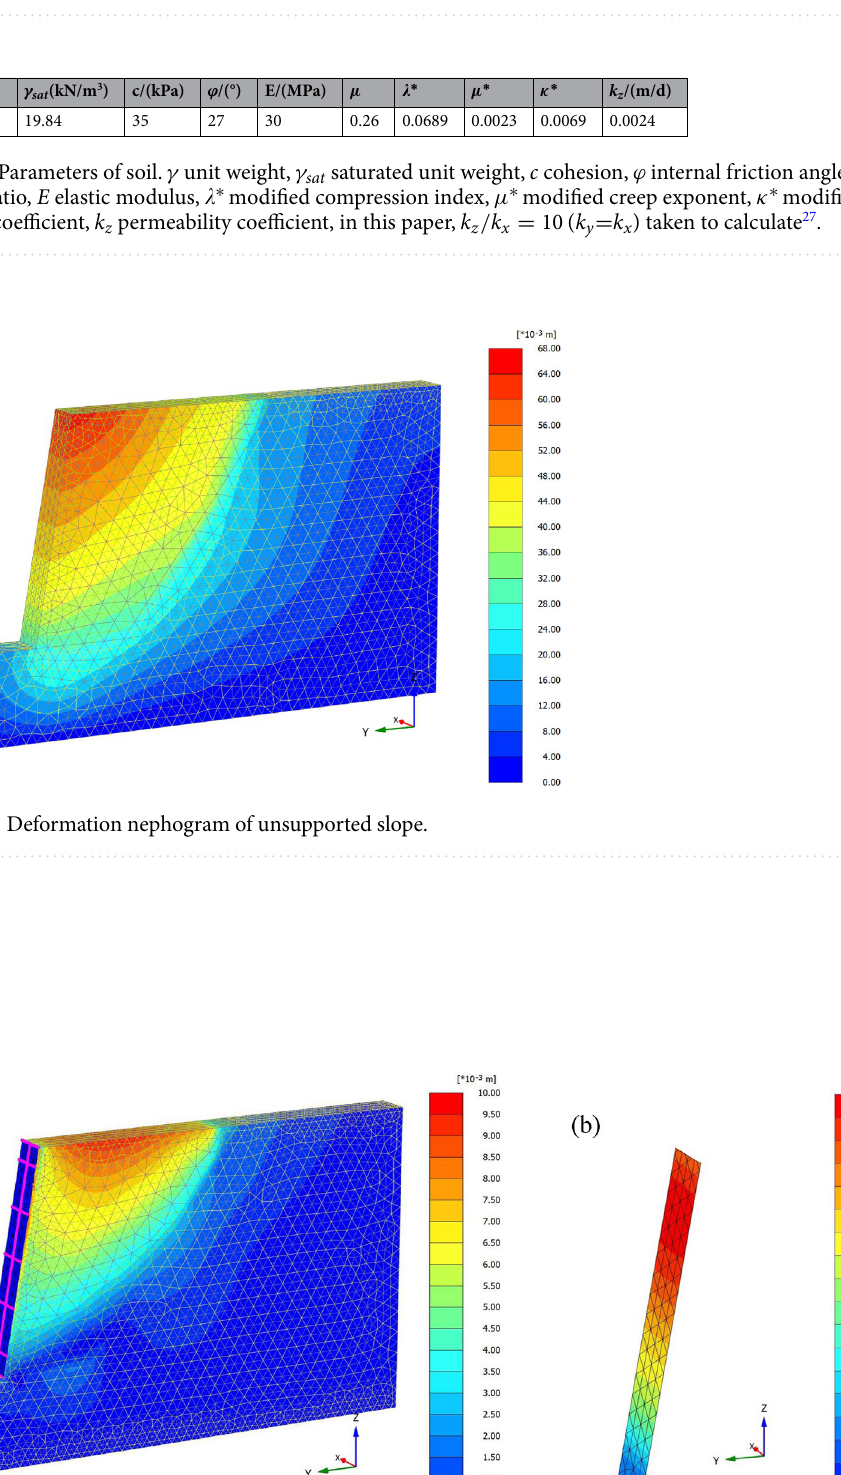
Table 4. Parameters of the supporting structure.